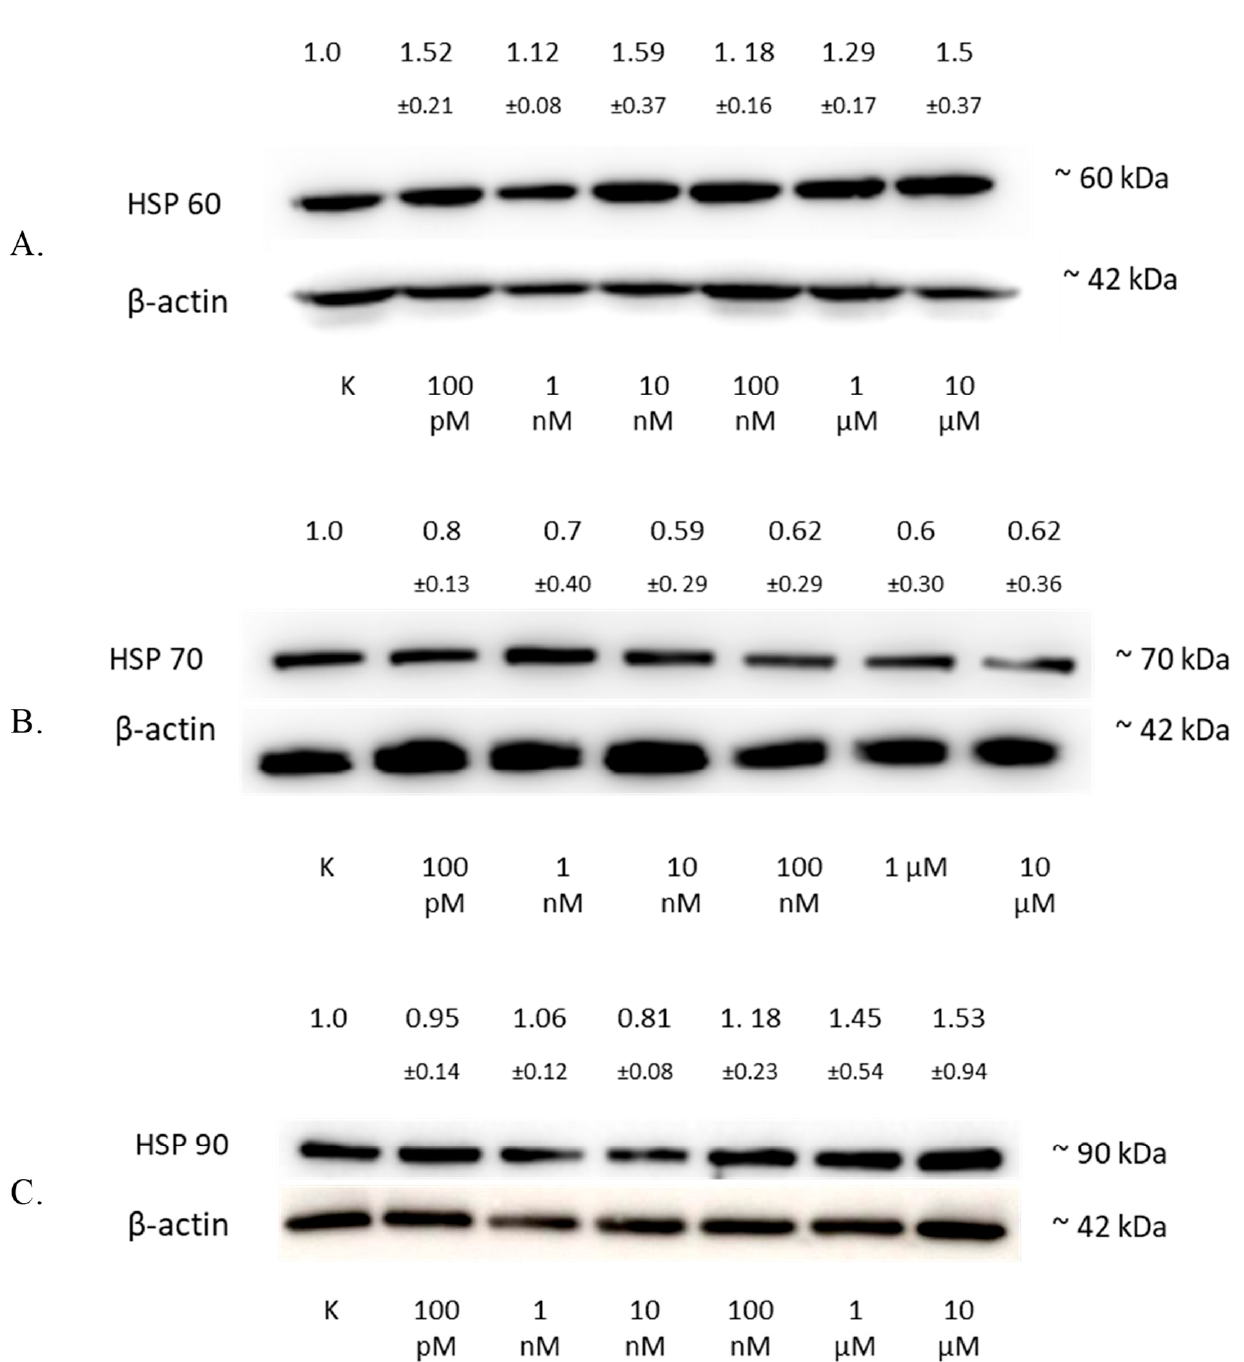
Figure 6. The influence of 2-ME on HSP in SW1088 cells. ( A ) The effect on HSP60 levels in the SW1088 glioma cell line treated with 100 pM–10 µ M 2-ME was assessed by Western blot analysis. ( B ) The effect on HSP70 levels in the SW1088 glioma cell line treated with 100 pM–10 µ M 2-ME was assessed by Western blot analysis. ( C ) The effect on HSP90 levels in the SW1088 glioma cell line treated with 100 pM–10 µ M 2-ME was assessed by Western blot analysis. Densitometric analysis of HSP60/ β -actin, HSP70/ β -actin, and HSP90/ β -actin ratios were performed using Quantity One 4.6.6 software. Representative immunoblots from one membrane are shown. Values are the mean ± SD of three independent experiments. 4. Discussion 2-ME inhibits the proliferation of human glioblastoma cell lines. It induces apoptosis in SW1088 cells at both physiologically and pharmacologically relevant concentrations,